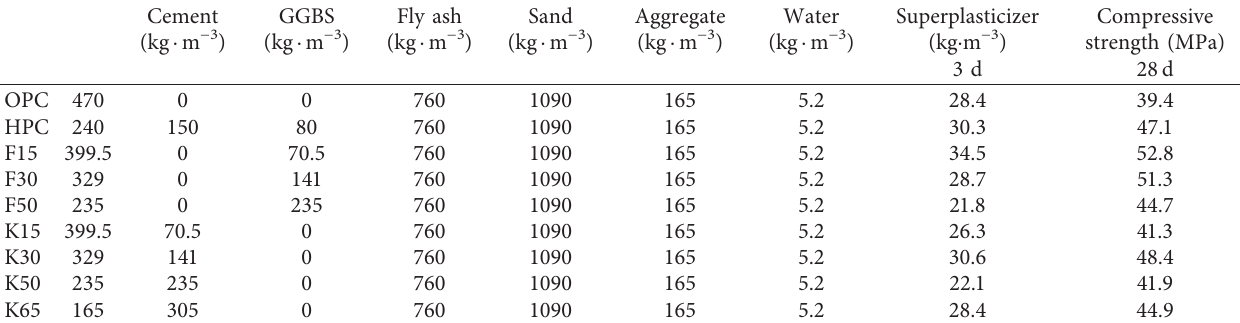
Table 1: Mix proportions of concrete and their compressive strength and air content of fresh concrete.